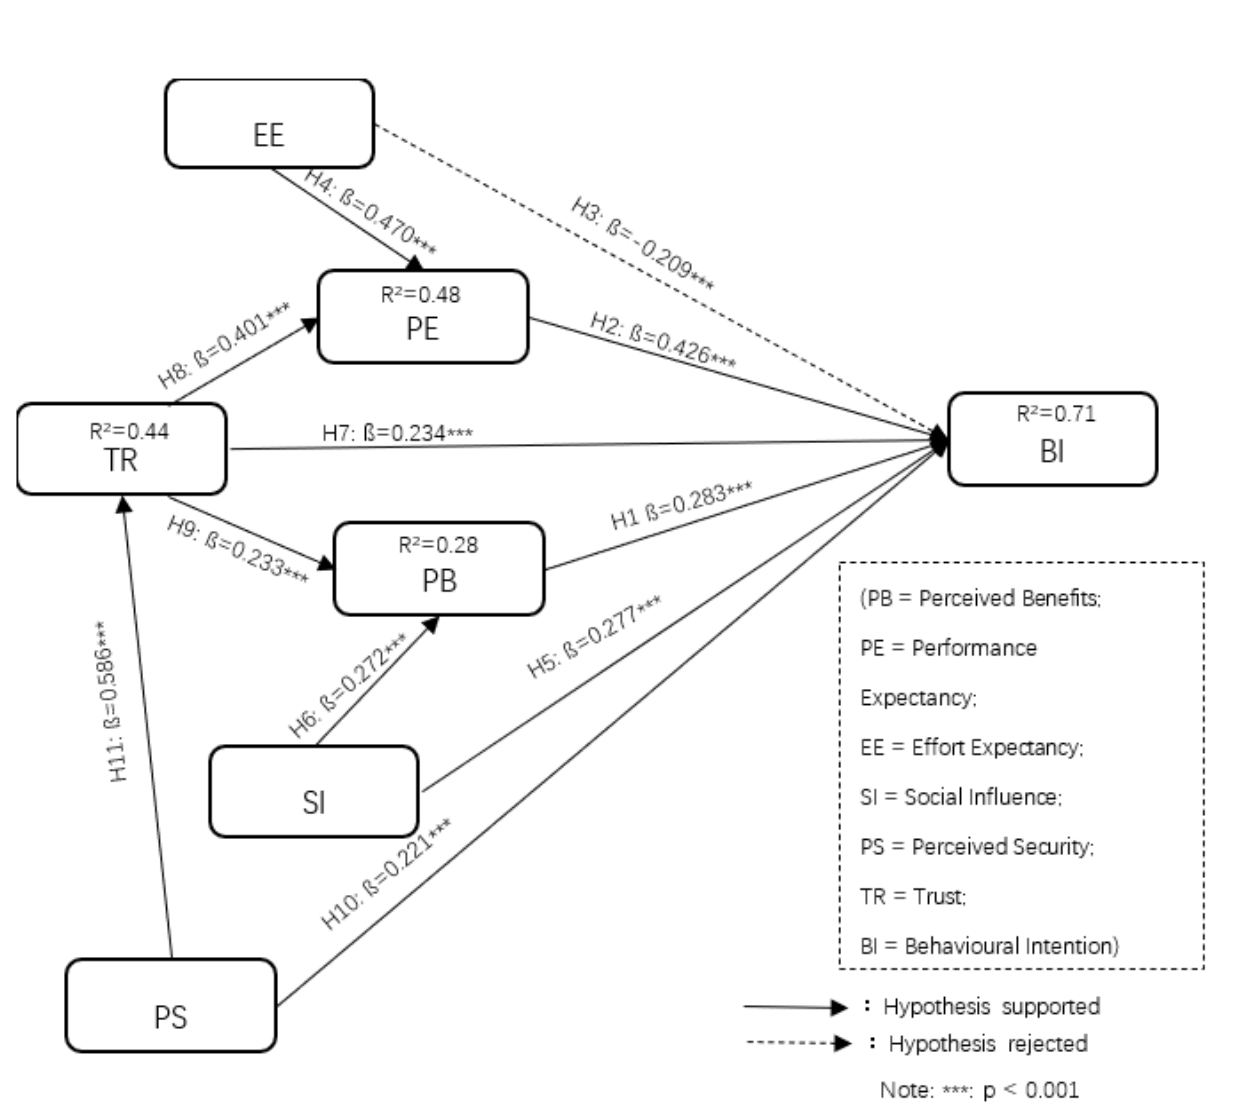
Figure 2. Hypotheses testing results.